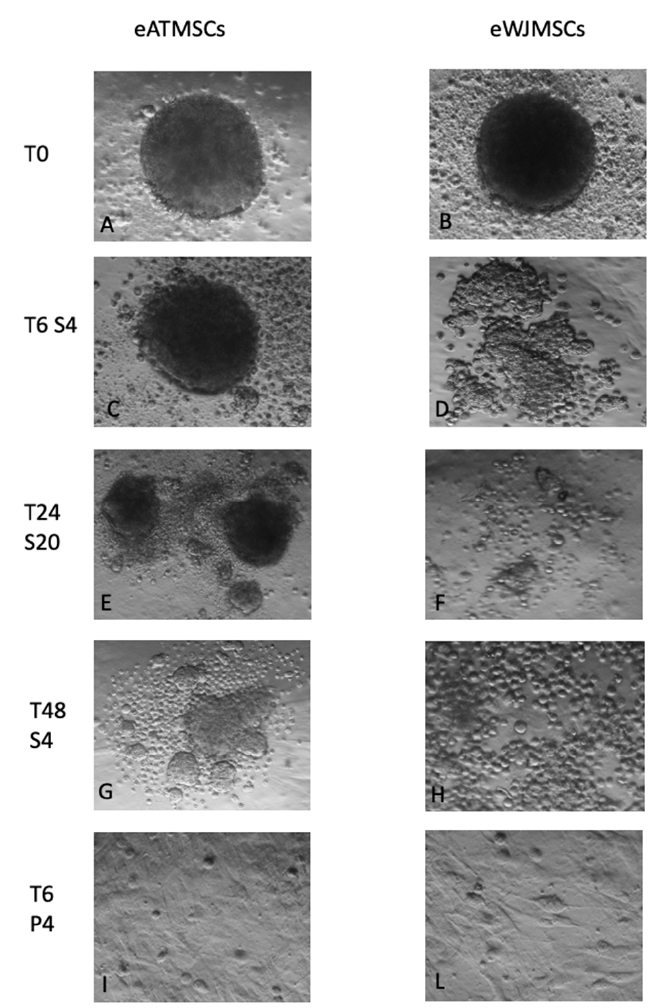
Figure 5. Spheroid formation assay performed with eATMSCs and eWJMSCs. ( A , B ) spheroids at T0. As showed in the pictures eATMSCS stored for 6 hrs in saline solution were able to form spheroids ( C ), but after 24 and 48 hrs of storage they formed smaller and fragmented spheroids ( E , G ). On the contrary in saline solution stored eWJMSCs were not able to form spheroids ( D , F , H ). Both cell lines stored in plasma lost their ability to form spheroids and grew adherent to plastic with a fibroblast like form ( I , L ). Magnification 10 ×